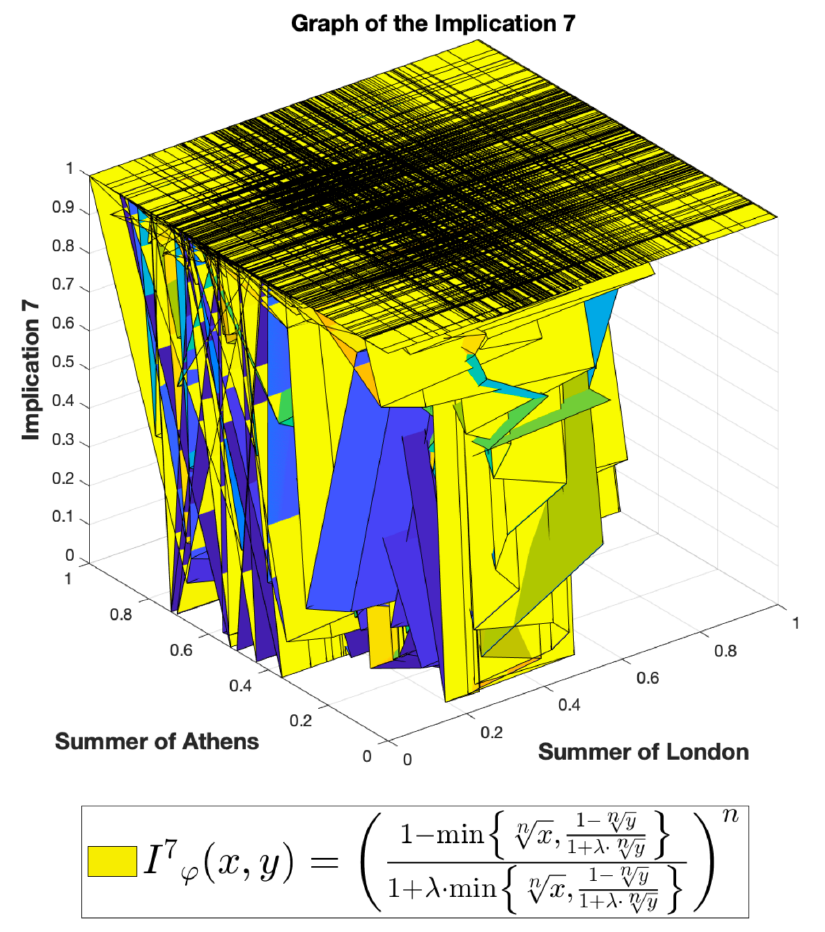
Figure 9. Graph of the Implication